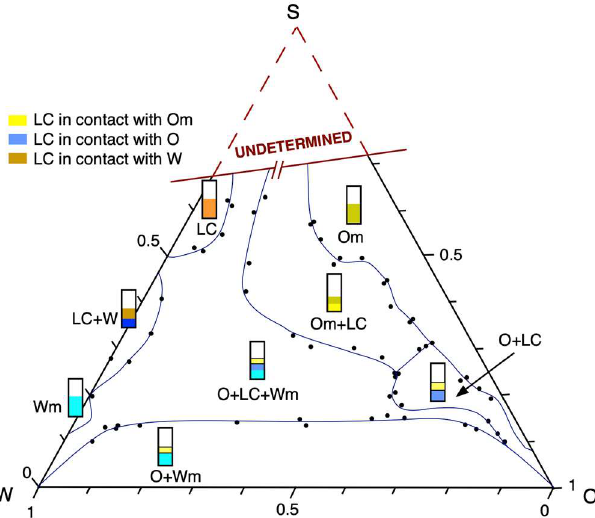
Figure 1. Diagram of phase behavior for the pseudo-ternary system of non-ionic surfactants with HLB of 12 (S), liquid paraffin (O), and water (W) at 30 °C. The systems were drawn according to their densities (the most dense phase at the bottom of the tube).